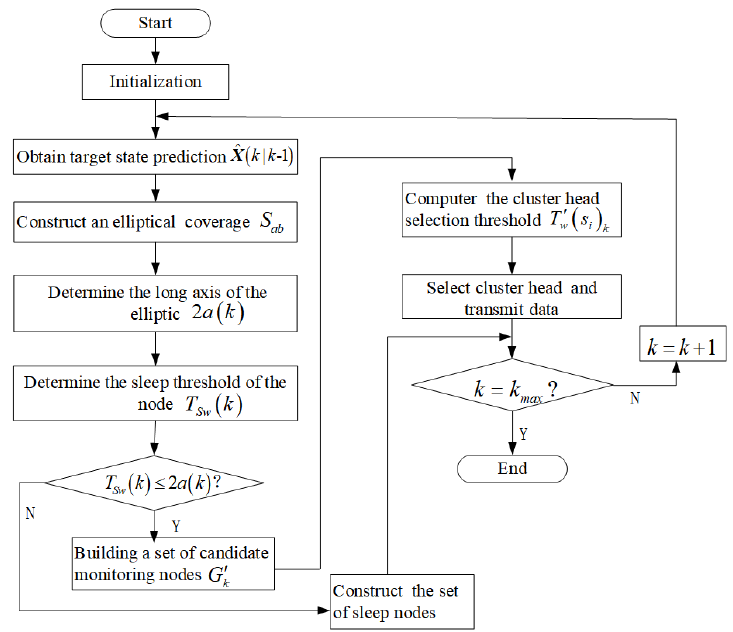
Figure 1. LEACH-MTC algorithm flow